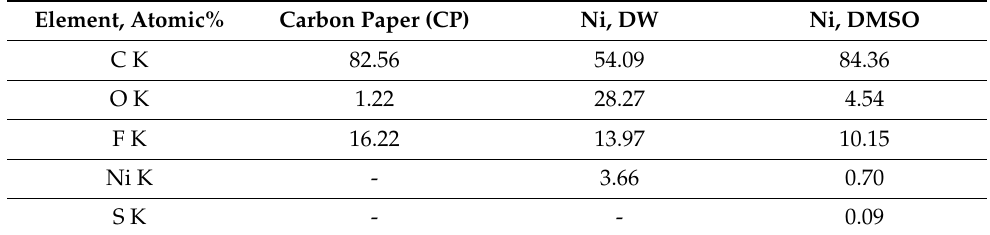
Table 1. Energy-dispersive X-ray spectroscopy (EDX) analysis of nickel catalyst deposited from various solutions: DW and